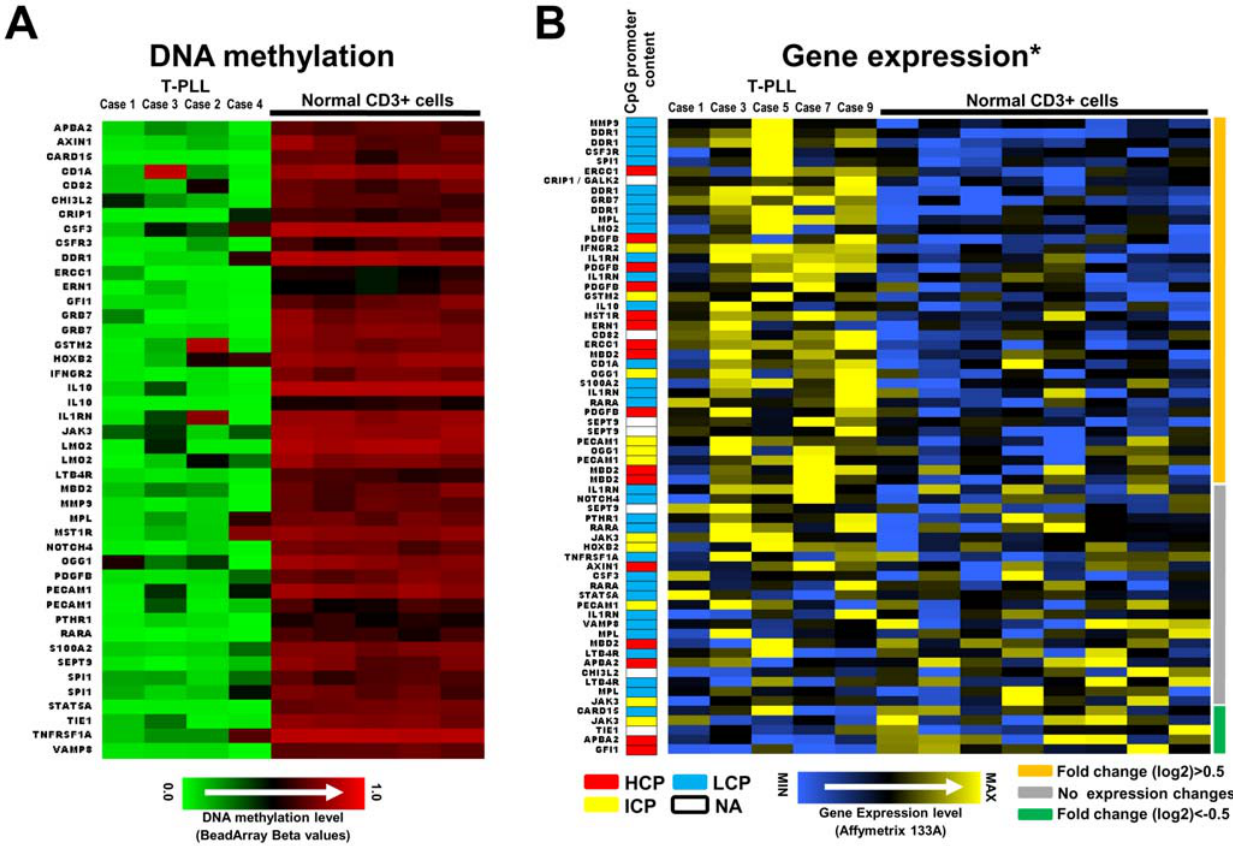
Figure6. Most genes showing hypomethylation of promoter regions in T-PLL are associated with increased gene expression. (A) Genes hypomethylated in T-PLL as compared with CD3 + normal T cells. Genes are arranged alphabetically. (B) Gene expression of hypomethylated genes in T- PLL cases as compared to CD3 + normal T cells. Genes are arranged according to their differential expression in T-PLL vs. normal controls (most upregulated genes on the top). Genes showing at least a 0.5 fold increase (in log2 scale), no expression changes or a 0.5 fold decrease are marked with orange, grey or green lines, respectively, on the right of the heatmap. The CpG content of the promoter sequences of the genes presented is depicted as color code in a separate column (low CpG content (LCP)=blue, intermediate CpG content (ICP)=yellow, high CpG content (HCP)=red, white=data not available). Two of the T-PLL cases (case 1 and case 3) have been studied both by DNA methylation and gene expression profiling. The normal CD3 + T cells used for DNA methylation and gene expression profiling were different. * Gene expression data have been published before by Du¨rig et al.